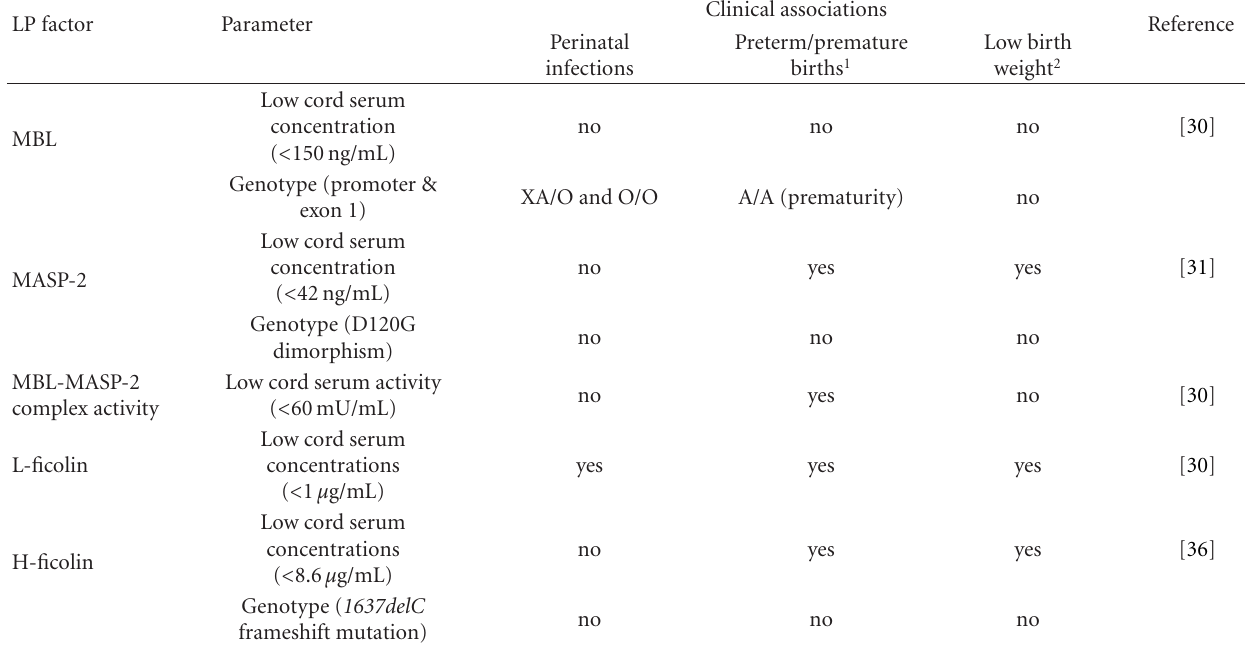
Table 2: Some clinical associations of selected complement lectin pathway factors, based on own